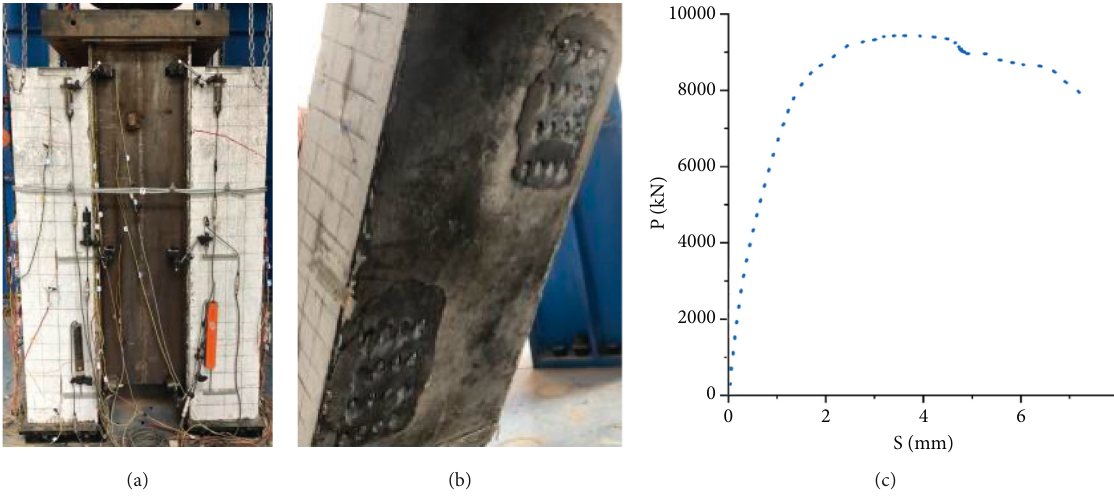
Figure 5: Process and result of push-out test. (a) Specimen loading. (b) Load to failure. (c) Load-slip